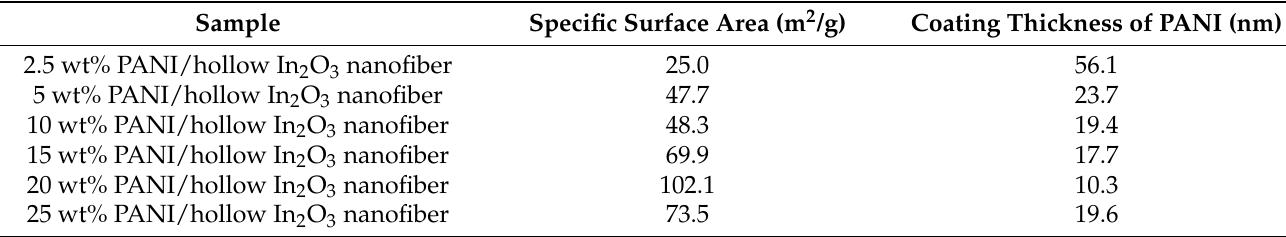
Figure 3. FTIR spectra of ( a ) hollow In 2 O 3 nanofiber, ( b ) neat PANI polymer matrix, ( c ) 2.5 wt% PANI/hollow In 2 O 3 nanofiber, ( d ) 5 wt% PANI/hollow In 2 O 3 nanofiber, ( e ) 10 wt% PANI/hollow In 2 O 3 nanofiber, ( f ) 15 wt% PANI/hollow In 2 O 3 nanofiber, ( g ) 20 wt% PANI/hollow In 2 O 3 nanofiber, and ( h ) 25 wt% PANI/hollow In 2 O 3 nanofiber composites. Table 1. Data of the specific surface area and the coating thickness of the PANI layer for the PANI/hollow In 2 O 3 nanofiber